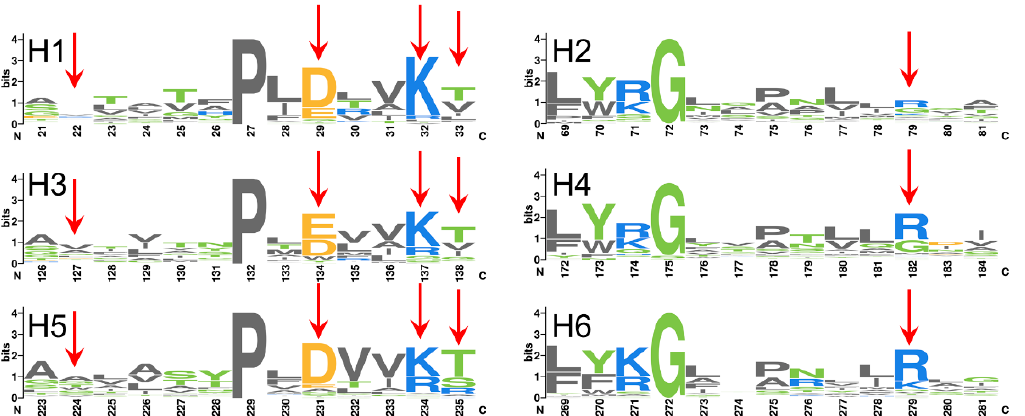
Figure 9. Sequence logo presentation of 53 human mitochondria carriers. Only residues around the m-gate level in odd-numbered helices ( left ) and even-numbered helices ( right ) are shown. Triplet positions at least with one charged residue in AAC are highlighted with red arrows.